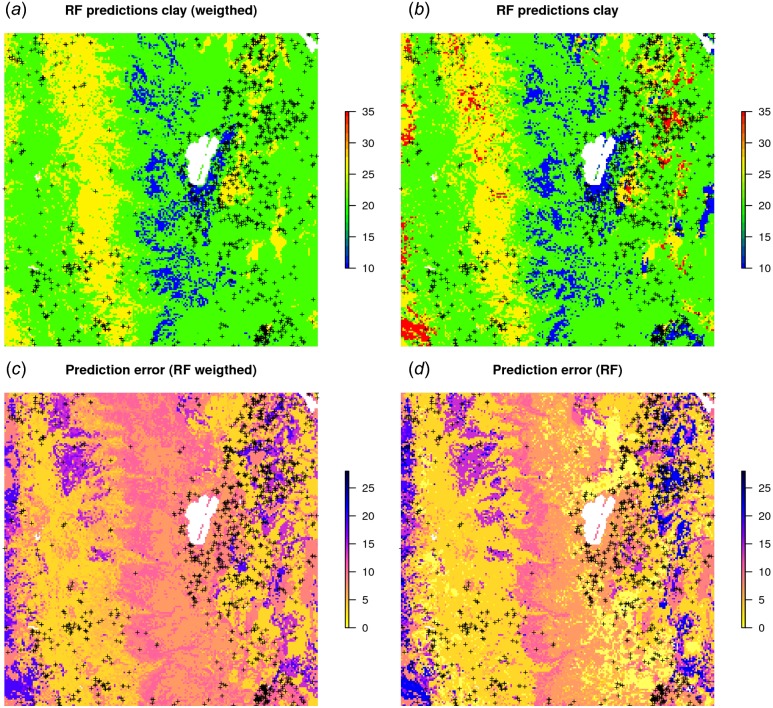
RF predictions (A–B) and prediction error standard deviations (C–D) for clay content with and without using measurement errors as weights.Study area around Lake Tahoe, California, USA. Point data sources: National Cooperative Soil Survey (NCSS) Characterization Database and National Soil Information System (NASIS) (Ramcharan et al., 2018).